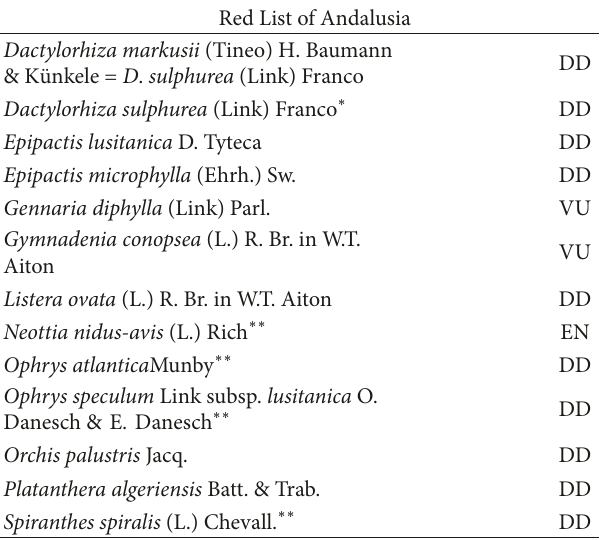
Table 7: Species included in the regional catalogue (RC) of Basque Country (ORD. 3471/1998).